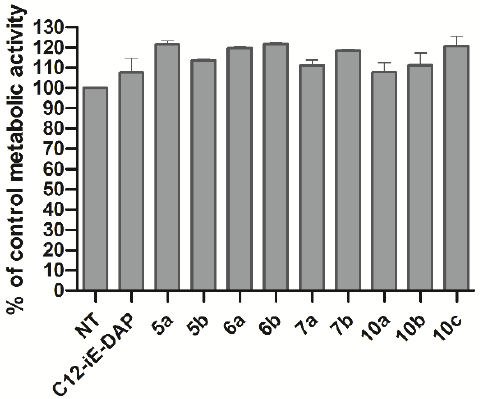
Figure 2. Proliferation rates of NOD1-specific HEK-Blue cells following 20 h of incubation with C12-iE-DAP (100 nM) and compounds 5a – b , 6a – b , 7a – b , 10a – c (10 µ M). The rates, expressed as means of duplicates ± S.E.M. of two independent experiments, are shown relative to that of the control (NT).